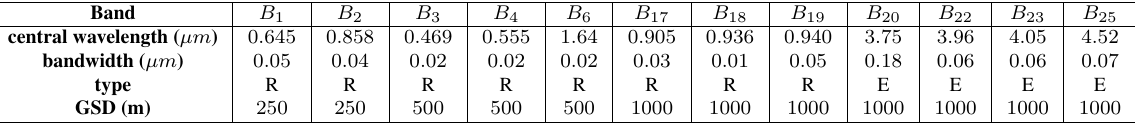
Table 1: The 12 potentially useful MODIS reflective (R) and emissive (E) channels, with their respective central wavelength, bandwidth and pixel Ground Sampling Distance